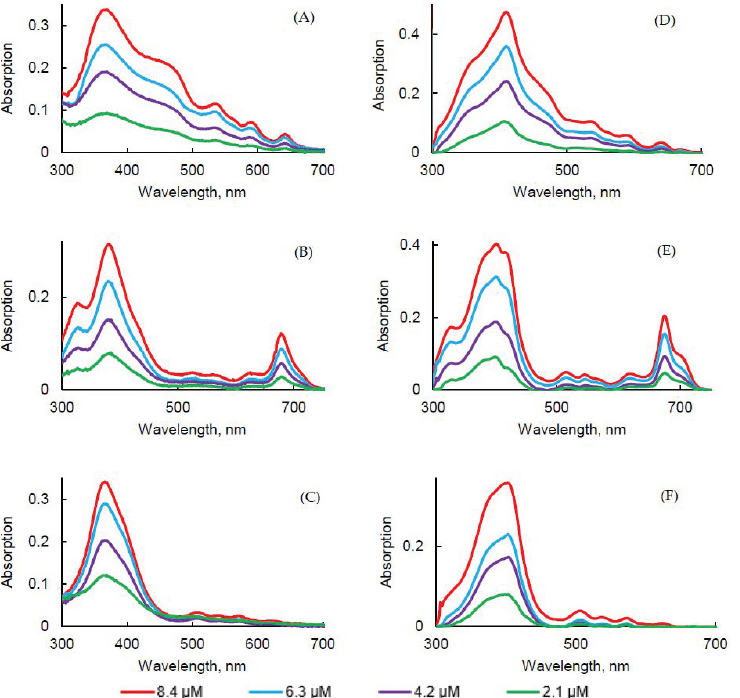
Figure 8. UV-visible absorption spectra of PpIX ( A , D ), PPa ( B , E ), and PF ( C , F ) in PBS ( A – C ) and FBS ( D – F ) at different concentrations.